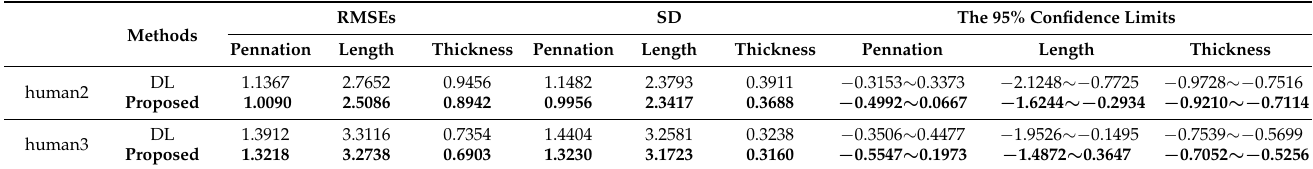
Table 4. The DL method and the proposed method are compared with the manual method of two other